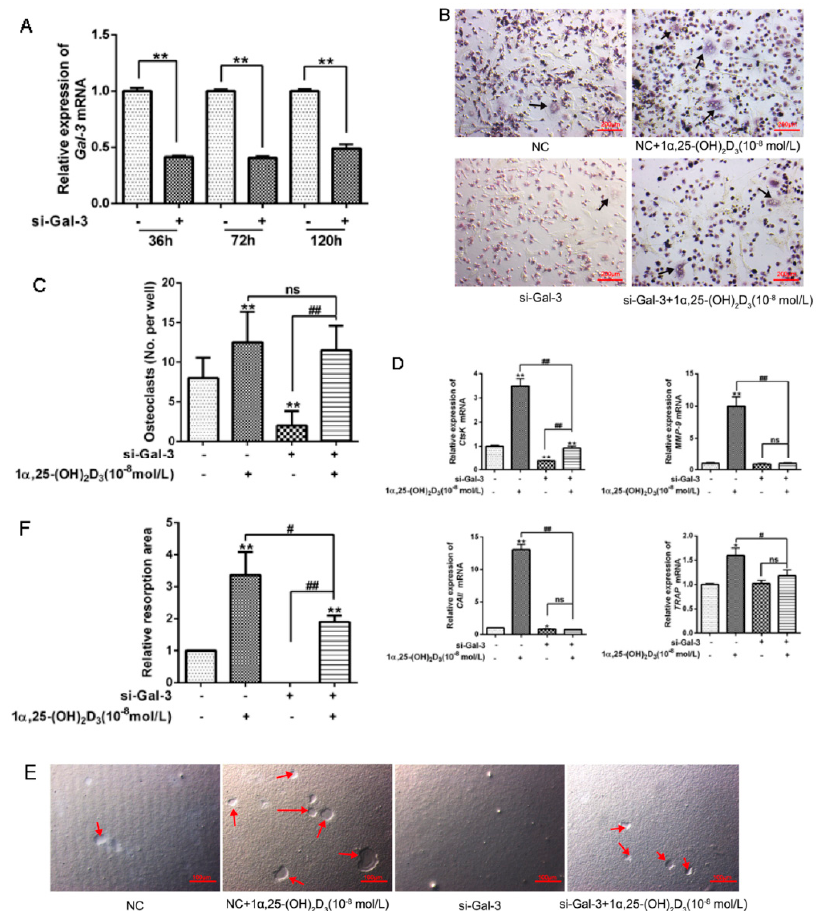
Figure 4. Gal-3 knockdown in BMSCs decreases the promoting effects of 10 − 8 mol/L 1 α ,25(OH) 2 D 3 on osteoclastogenesis and bone resorption. ( A ) BMSCs were transfected with si-Gal-3 or NC siRNA for 10 h before being cultured in α -MEM for 36, 72, or 120 h. Quantitative RT-PCR was used to quantitate the expression of Gal-3 mRNA ( n = 3 per group). ( B , C ) After Gal-3 knockdown in BMSCs, BMSCs and BMMs were co-cultured on 6-well plates with or without addition of 1 α ,25(OH) 2 D 3 . Cells were cultured for 5 days. NC was the blank control. Ten fields were randomly selected. The number of TRAP-positive multinucleated OCs (black arrows) was counted. Bar = 200 μ m. ( D ) After Gal-3 knockdown, BMSCs were co-cultured with BMMs with or without addition of 1 α ,25(OH) 2 D 3 . Cells were cultured for 5 d. NC was the blank control. Quantitative RT-PCR was used to quantitate the mRNA expression of OC marker genes ( CtsK , CAII, MMP-9 , and TRAP ) ( n = 3 per group). ( E , F ) After BMSCs were seeded in 96-well bone resorption culture plates and Gal-3 was knocked down, BMSCs and BMMs were co-cultured with or without ad- dition of 1 α ,25(OH) 2 D 3 . Cells were cultured for 5 days. NC was the blank control. An inverted microscope was used for obser- vation of 10 randomly selected fields. Image-Pro Plus 6.0 software was used to analyze the area of bone resorption pits (red arrows). Bar = 100 μ m. (Graph bars show mean ± SD. * p < 0.05 and ** p < 0.01 show significant difference compared with the NC control group. # p < 0.05 and ## p < 0.01 show significant difference compared with the 1 α ,25(OH) 2 D 3 -treated si-Gal-3